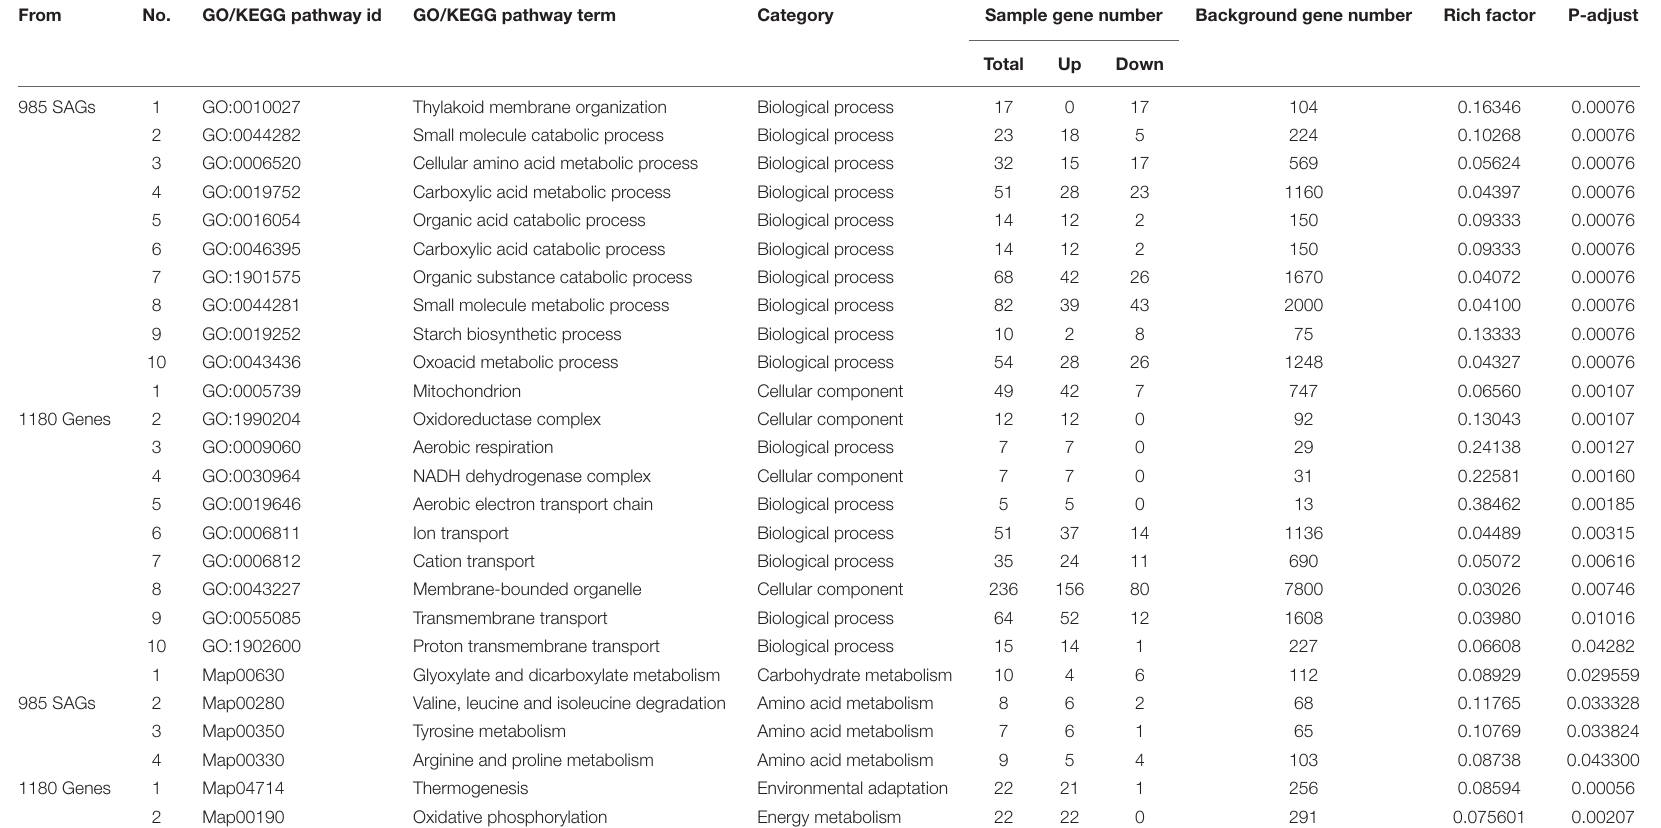
TABLE 1 | Gene ontology (GO) and Kyoto Encyclopedia of genes and genomes (KEGG) pathways enrichment analysis of DEGs ( Figure 3B , 985 SAGs and 1,180 genes) shared by darkness and alkaline-induced leaf senescence at three time points. From No. GO/KEGG pathway id GO/KEGG pathway